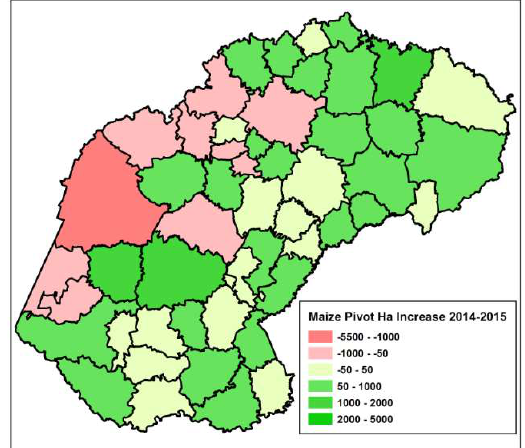
Figure 37. Wheat in winter only under pivot irrigation increase or decrease per district between 2014 and 2015